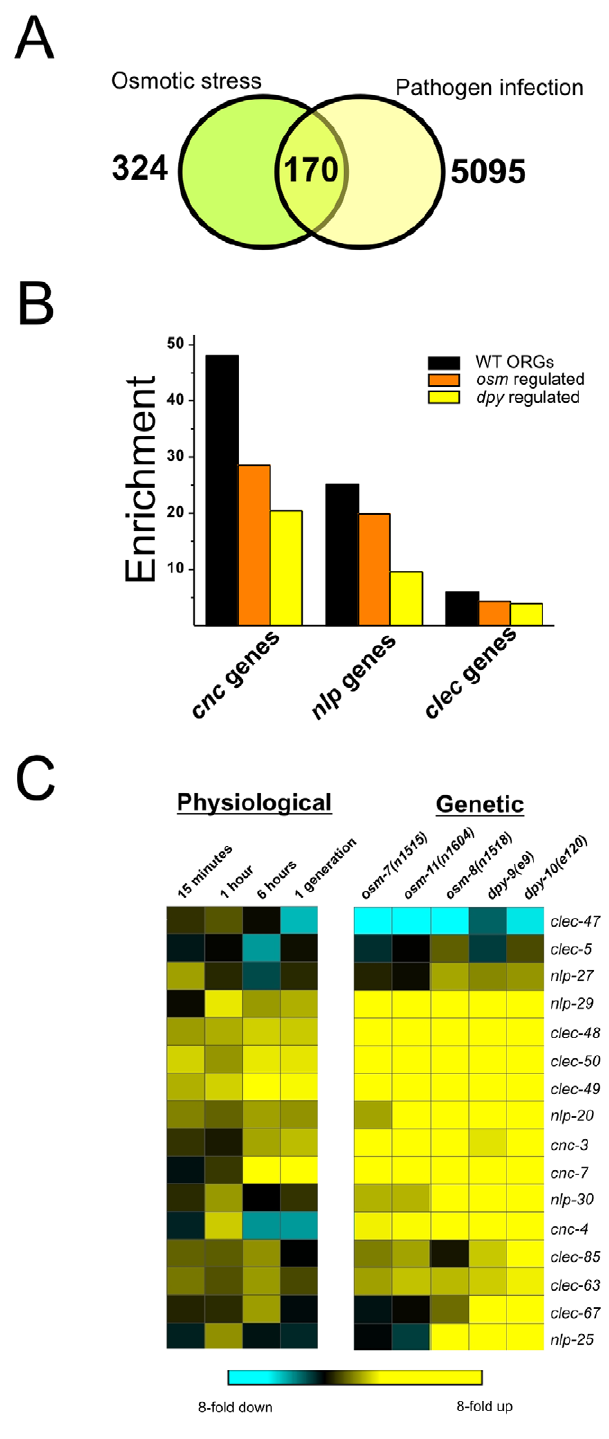
Figure 2. Osmotically regulated genes exhibit significant overlap with pathogen regulated genes. (A) Venn diagram showing the genes in common between osmotic stress and a compilation of all pathogen microarray data. Pathogen data were compiled from existing microarray datasets [10,12,25,26] to obtain 5095 unique genes that were significantly regulated in at least one model of infection. (B) Enrichment of the indicated gene class among genes regulated by osmotic stress in wild type or under isotonic conditions in osm and dpy mutants. (C) Hierarchical clustering of antimicrobial cnc , nlp , and clec gene expression in osmotically stressed wild type or unstressed osm and dpy